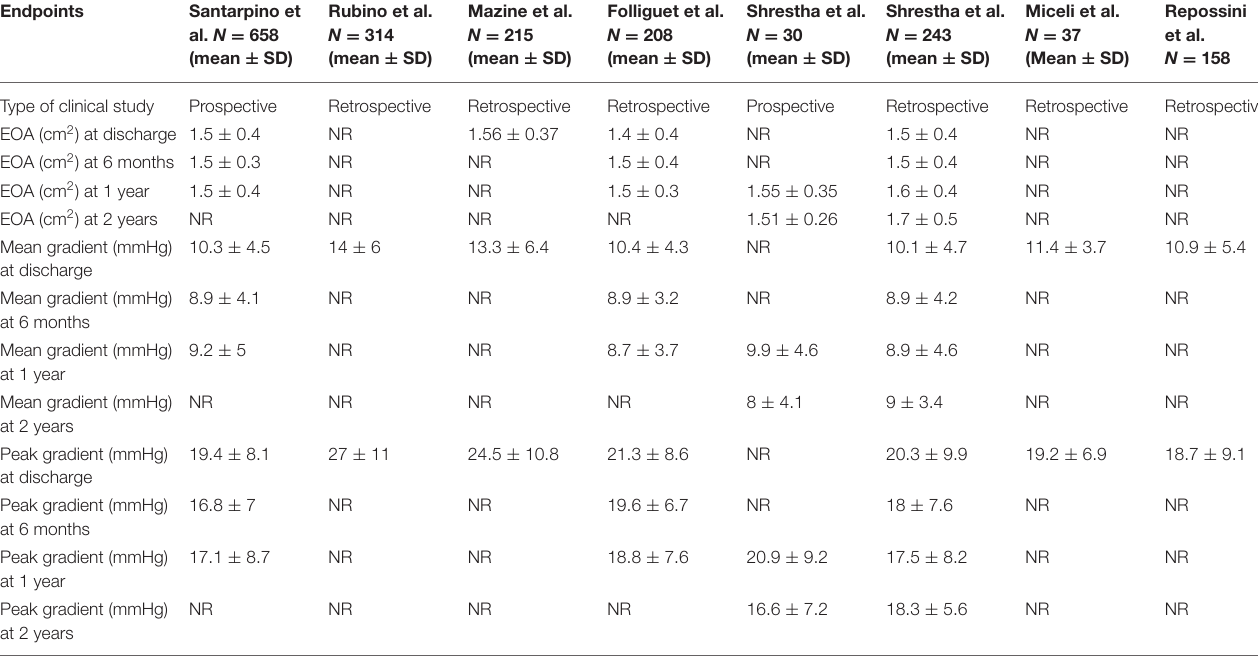
TABLE 4 | Hemodynamic